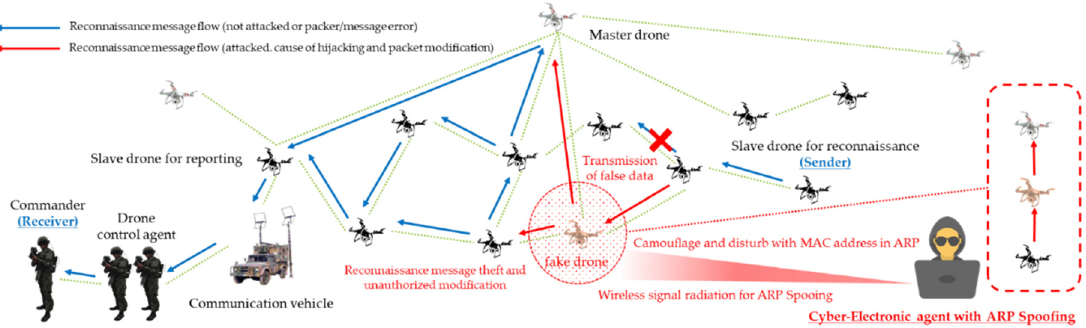
Figure 9. ARP (address resolution protocol) spoofing scenario for reconnaissance report in a swarming communication drones maneuvering system.